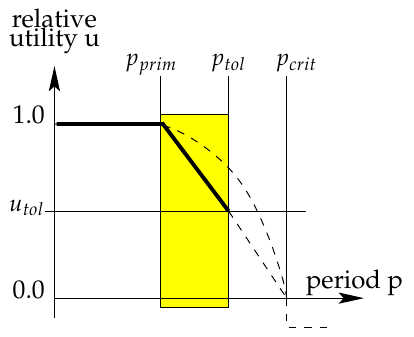
Figure 1. Utility function: calculating relative utility based on the chosen